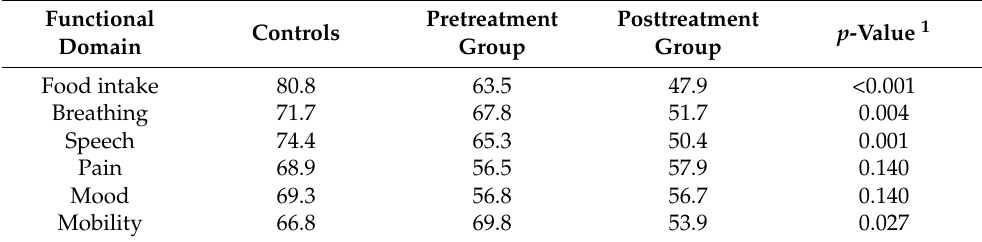
Table 2. Mean ranks in the Jonckheere–Terpstra tests for 6 functional domains in controls, HNC patients before treatment, and HNC patients after